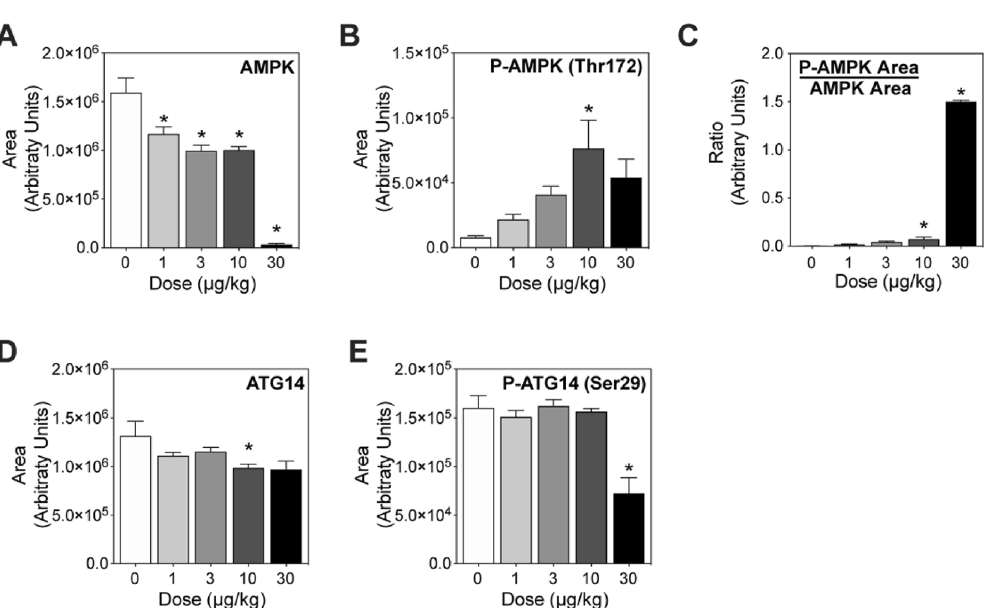
Figure 6. Markers of AMPK activation. Mice (n = 3–5) were orally gavaged every 4 days for 28 days with TCDD prior to tissue collection. Protein levels were assessed in hepatic extracts using capillary immunoassay analysis. ( A ) Total AMPK and ( B ) phosphorylated AMPK (P-AMPK) and ( C ) the P-AMPK/AMP ratio two were assessed. Capillary immunoassay analysis of ( D ) total ATG14 and ( E ) phosphorylated ATG14 at serine 29 (P-ATG14 Ser29), a marker of P-AMPK activation. Bar graphs denote the mean ± SEM. Significance (*p ≤ 0.05) was determined using a one-way ANOVA followed by Dunnett’s post-hoc analysis. Plots were created using GraphPad Prism